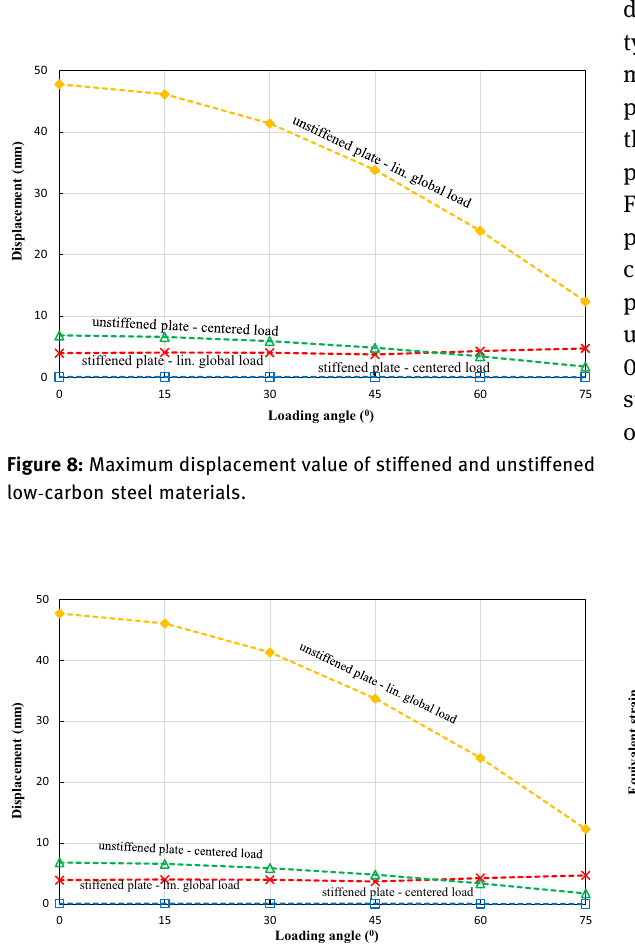
Figure 10: The equivalent strain of sti ff ened and unsti ff ened low - carbon steel